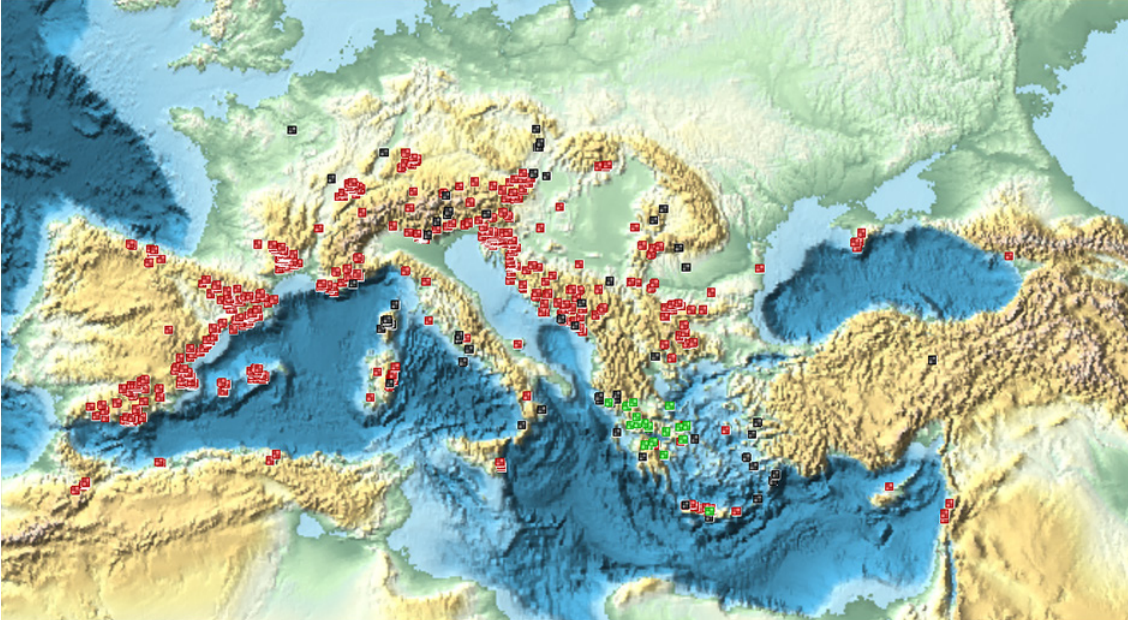
Fig. 213. Distribution map of Plusiocampinae Paclt, 1957 and tachycampoid phyletic lineage species in their habitats: subterranean, including natural and artificial caves (red squares), edaphic (black squares), MSS (green squares).